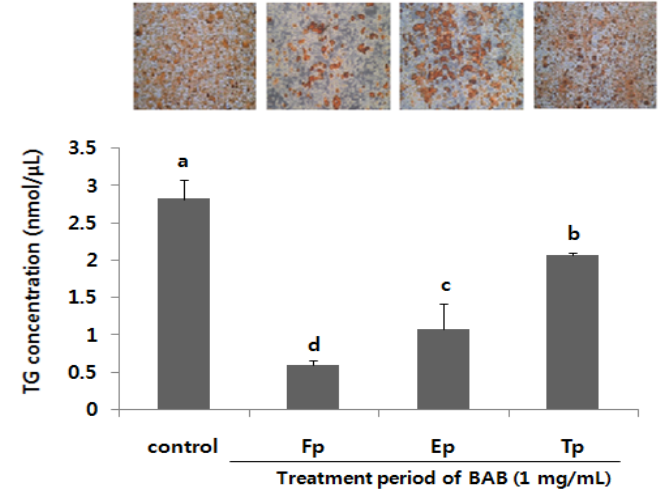
Figure 3. Lipid accumulation of differentiated adipocytes treated with or without black adzuki bean for the indicated period. Cells were measured for TG concentration and stained with Oil Red O and observed under the microscope. Data are expressed as means ± SD and a different small letter indicates a significant difference among groups, according to ANOVA with Duncan’s multiple range test ( p < 0.05). Fp: full period; Ep: early period; Tp: terminal period; BAB: black adzuki bean.